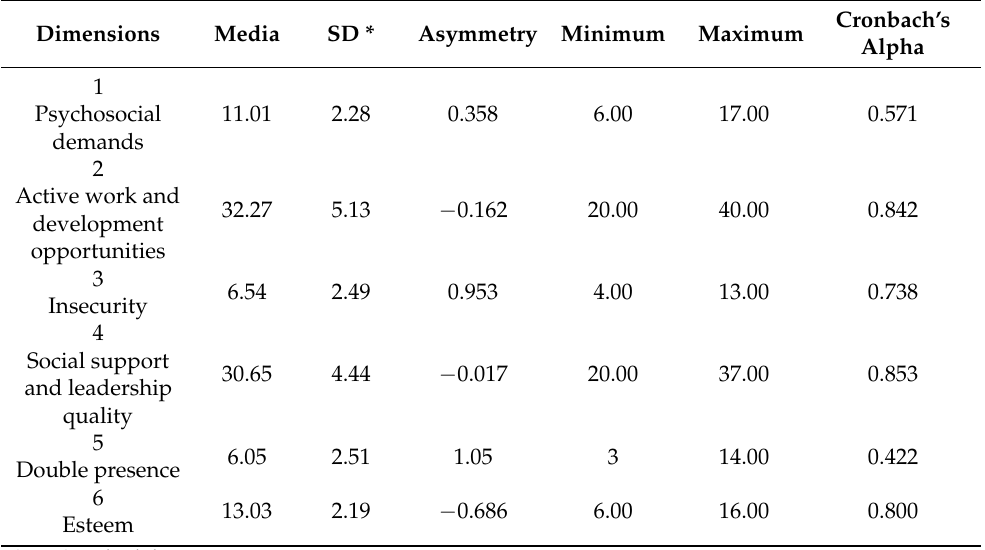
Table 4. Descriptives of the Psychosocial Risk Assessment Questionnaire in Non-Formal Contexts. Dimensions